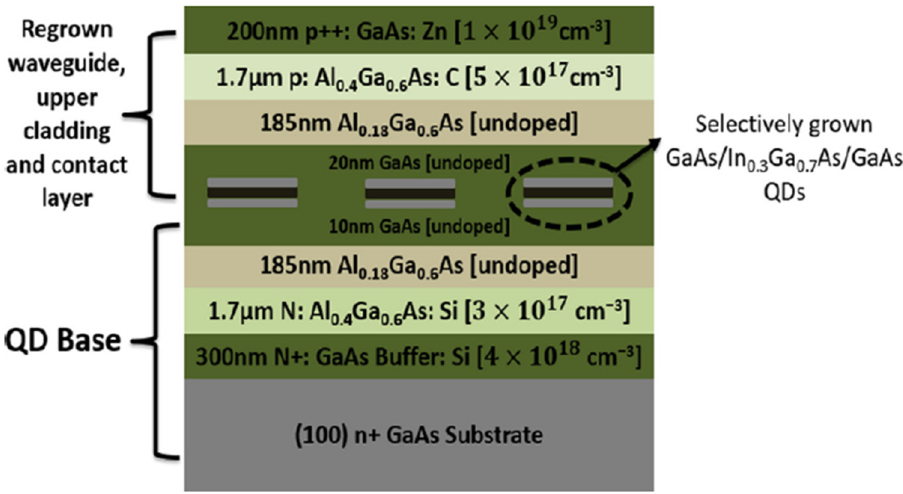
Figure 9. Structure of a InGaAs QD laser. The lower QD base was grown at 700 °C, and the upper regrown layers were grown at 625 °C. Reprinted with permission from ref. [48] © Elsevier. Copyright 2017 Journal of Crystal Growth.